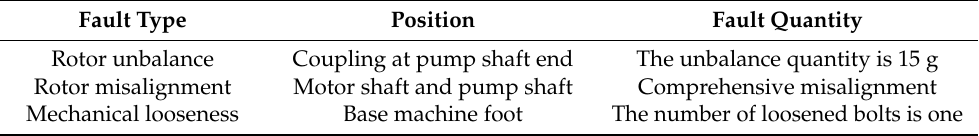
Table 2. Parameters of fault simulation. Fault Type Position Fault